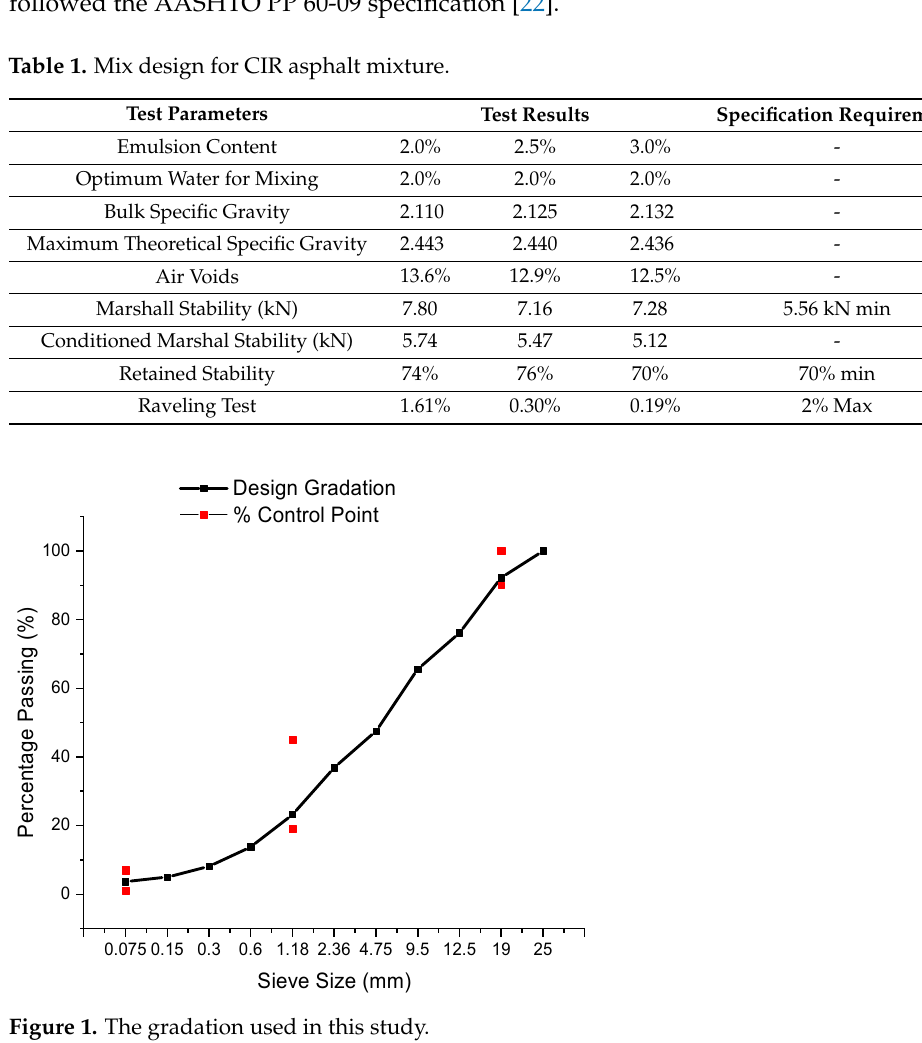
Figure 1. The gradation used in this